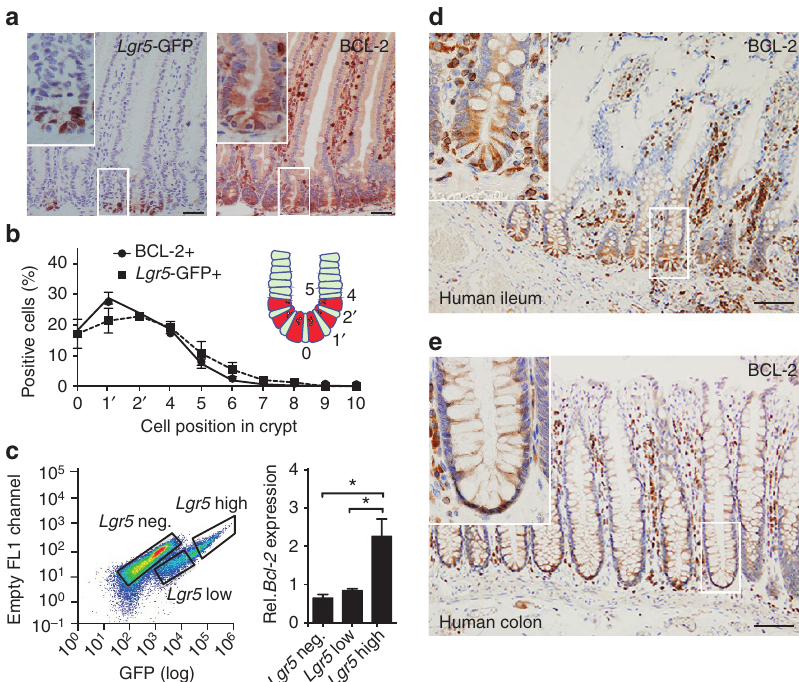
Figure 2 | Bcl-2 marks crypt base columnar ISCs. ( a ) Immunohistochemistry for GFP (left) and BCL-2 (right) stained sections of the small intestine of Lgr5 -GFP mice. BCL-2 staining shows a similar expression distribution as the Lgr5 -GFP þ cells within crypts. Scale bars, 50 m m. ( b ) Graph depicting the percentage of cells at particular cell positions within crypts that are positive for Lgr5 -GFP and BCL-2. A similar distribution of crypt base specific expression can be found in both cases. Error bars represent s.e.m. ( n ¼ 3 mice). ( c ) FACS graph indicating the sorting gates for Lgr5 -GFP negative , Lgr5 -GFP low and Lgr5 - GFP high cell populations (left) and bar graph depicting the relative messenger RNA (mRNA) expression of Bcl-2 within the indicated populations showing the highest expression in the Lgr5 -GFP high population (right panel). Error bars represent the s.e.m. ( n ¼ 3 mice), * P o 0.05, Student’s t -test. ( d ) BCL-2 staining of human ileum tissue. Scale bar, 50 m m. ( e ) BCL-2 staining of human colonic tissue. Scale bar, 50 m m.